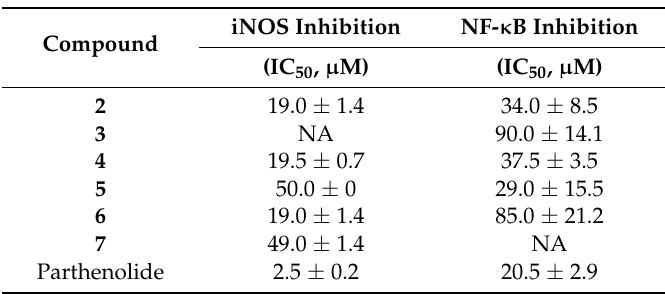
Table 1. Anti-inflammatory activity of synthetic